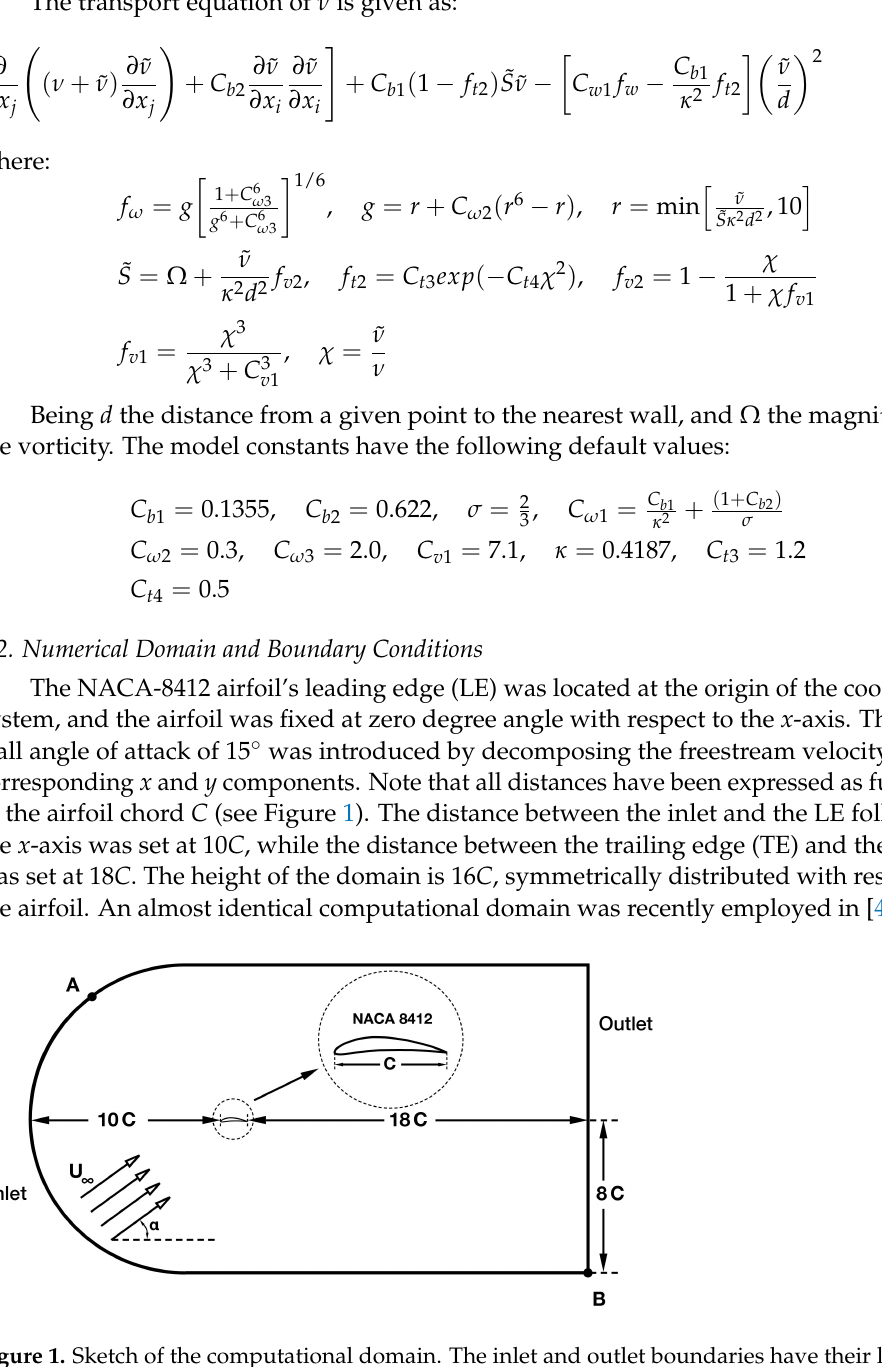
Figure 1. Sketch of the computational domain. The inlet and outlet boundaries have their limits in the points defined by the letters A and